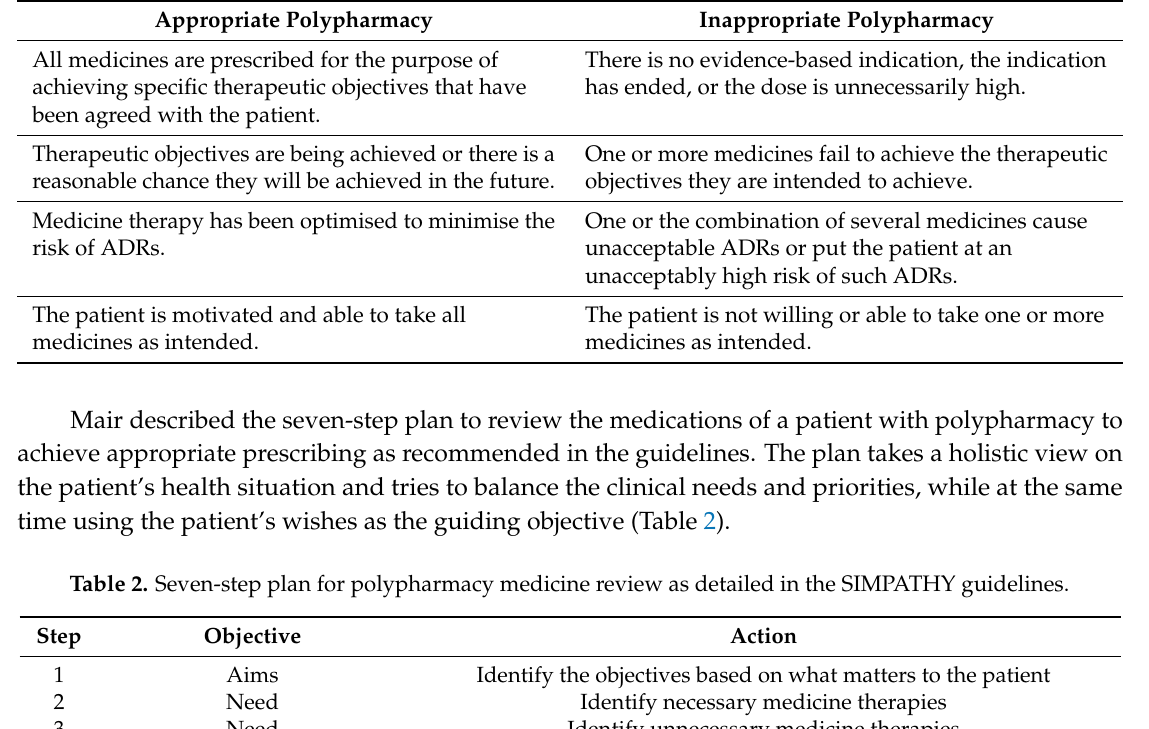
Table 1. Criteria for appropriate and inappropriate polypharmacy.